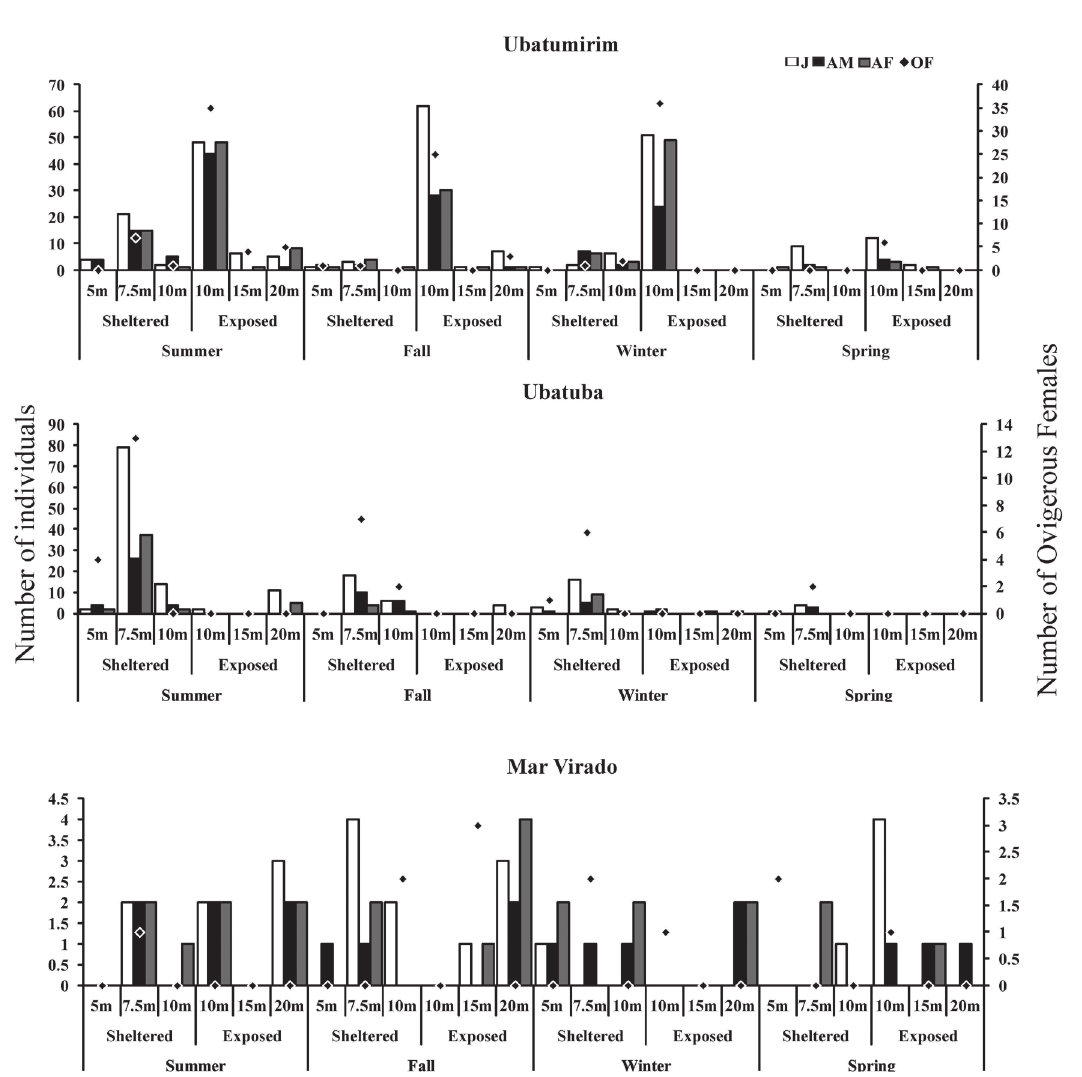
Figure 5. Hexapanopeus paulensis . Spatiotemporal distribution of individuals by bays, seasons, areas and sampling points, from January 1998 to December 1999. J = juveniles, AM = adult males, AF = adult females and OF = ovigerous Table 1. Hexapanopeus paulensis . Summary of results of Redundancy Analysis (RDA) for abundance of individuals (males and females) and environmental factors.